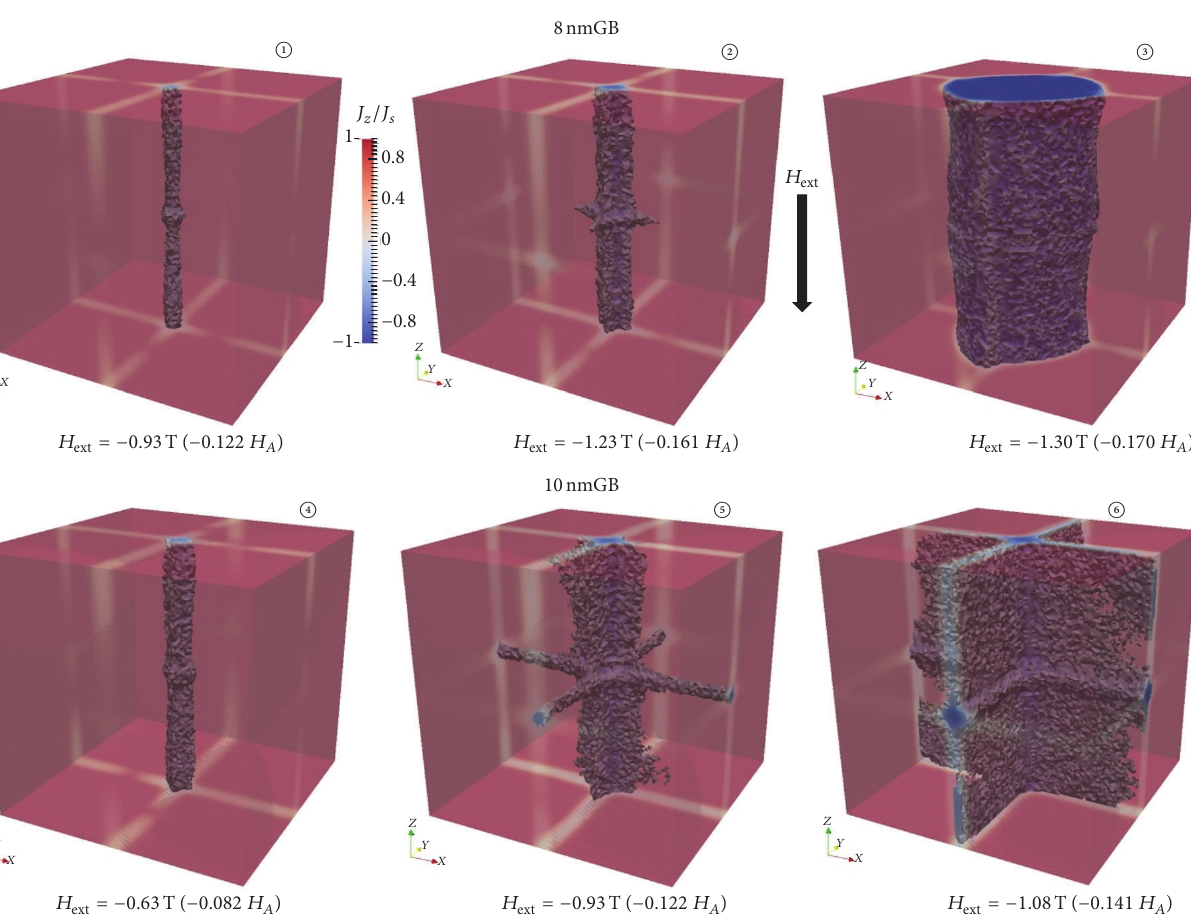
Figure 11: Visualization of the nucleation and propagation of the reversed magnetic domains in the 8-G model structure with a GB thickness of 8 nm ( A – C ) and 10 nm ( D – F ) with 𝜗 0 = 0 ∘